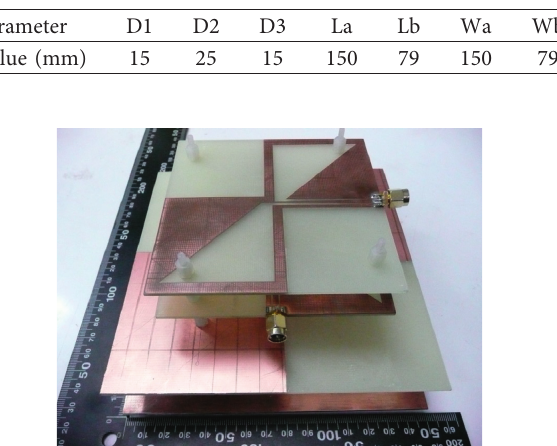
Figure 4: Implemented prototype of the proposed antenna.